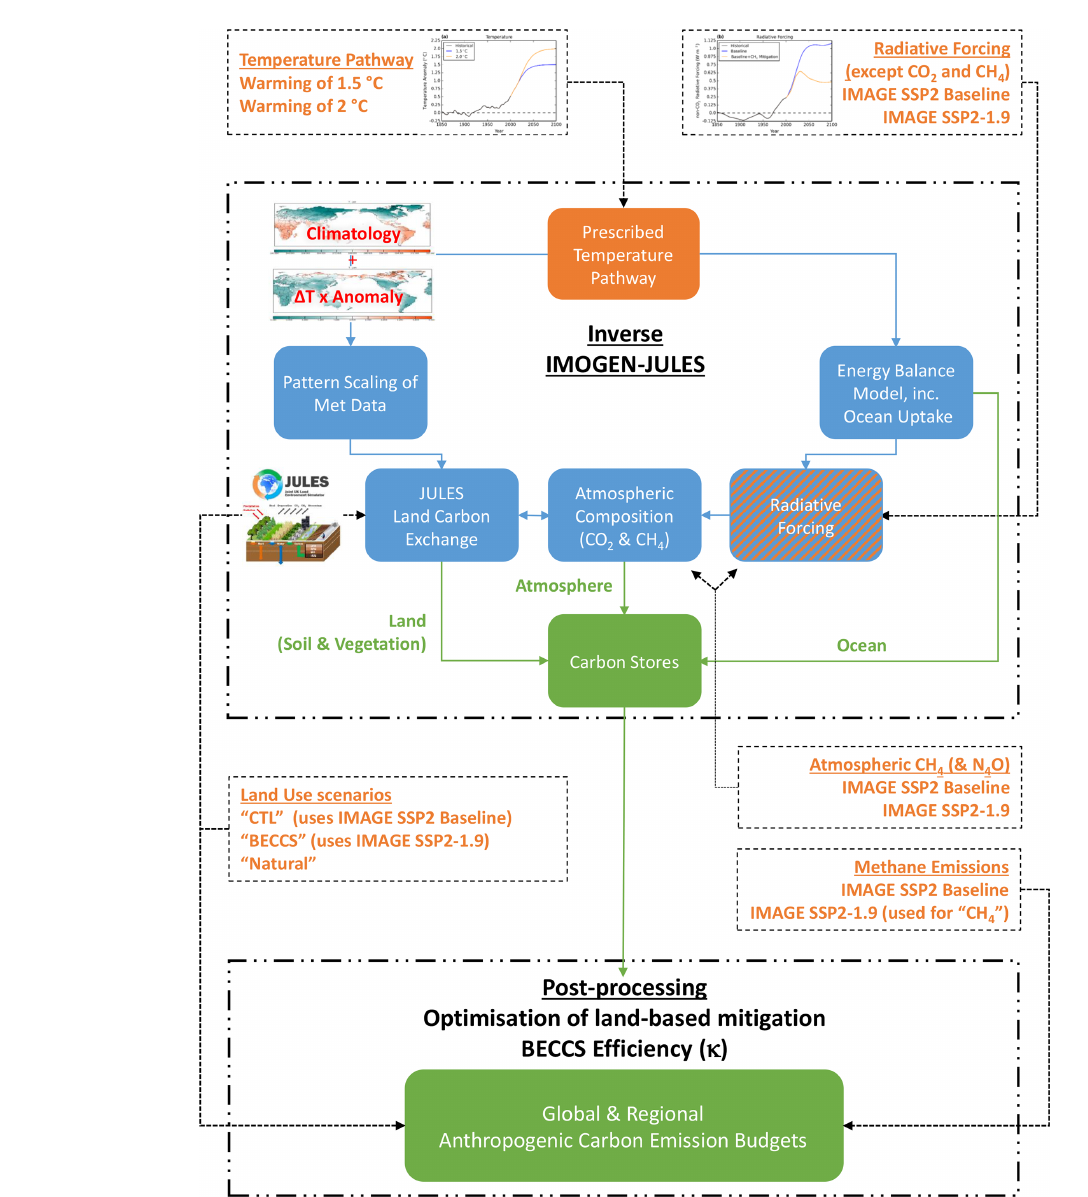
Figure 1. Schematic of the modelling approach and the workflow. The coloured boxes and text show the key components of the inverted IMOGEN-JULES model (blue), the prescribed and input data used in this study (orange), and the outputs